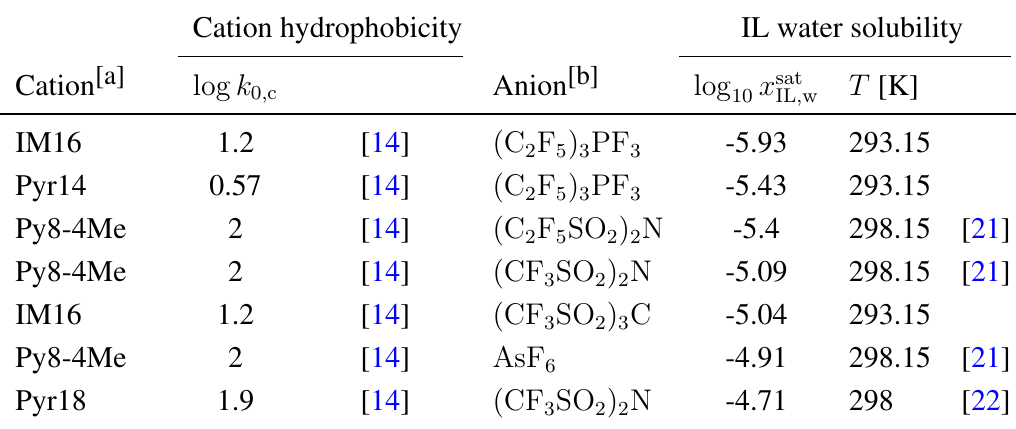
Table 3. Water solubility at temperatures within 293.15 ± 5 K and cation